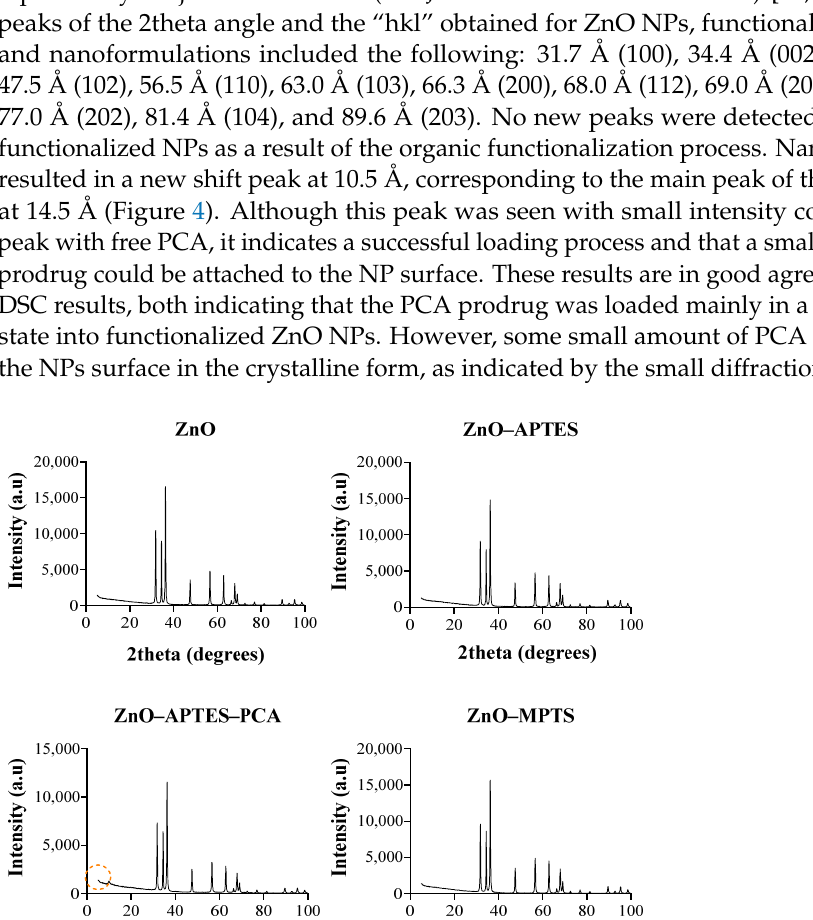
Figure 4. Results of X-ray diffraction analysis of dried powder materials for the PCA prodrug and before and after PCA loading in nanoformulations. The red-dotted circle indicates the presence of PCA in nanoformulations.